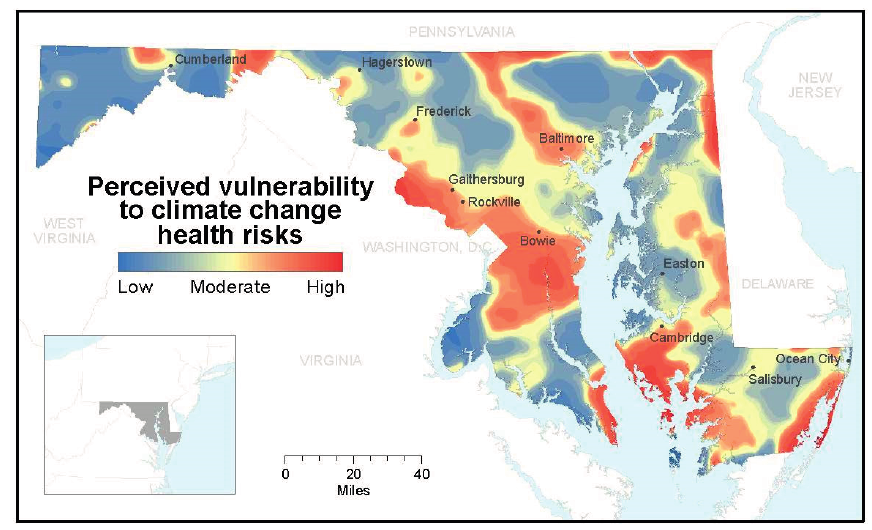
Figure 1. Geographic distribution of perceived vulnerability to climate change health risks demonstrated as a relative distribution by interpolating the factor score